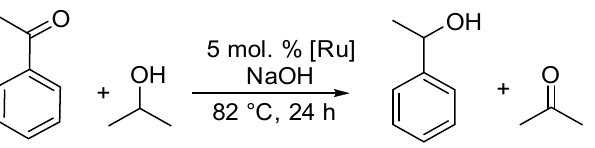
Figure 6. Intermolecular N–H···Cl interactions in the crystal structure of complex 3 .